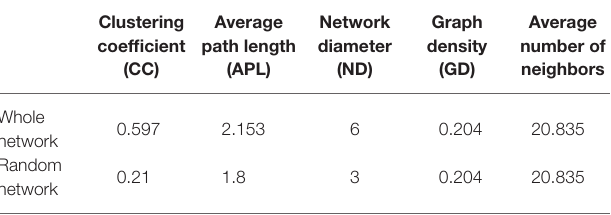
TABLE 2 | Topological properties of co-occurring